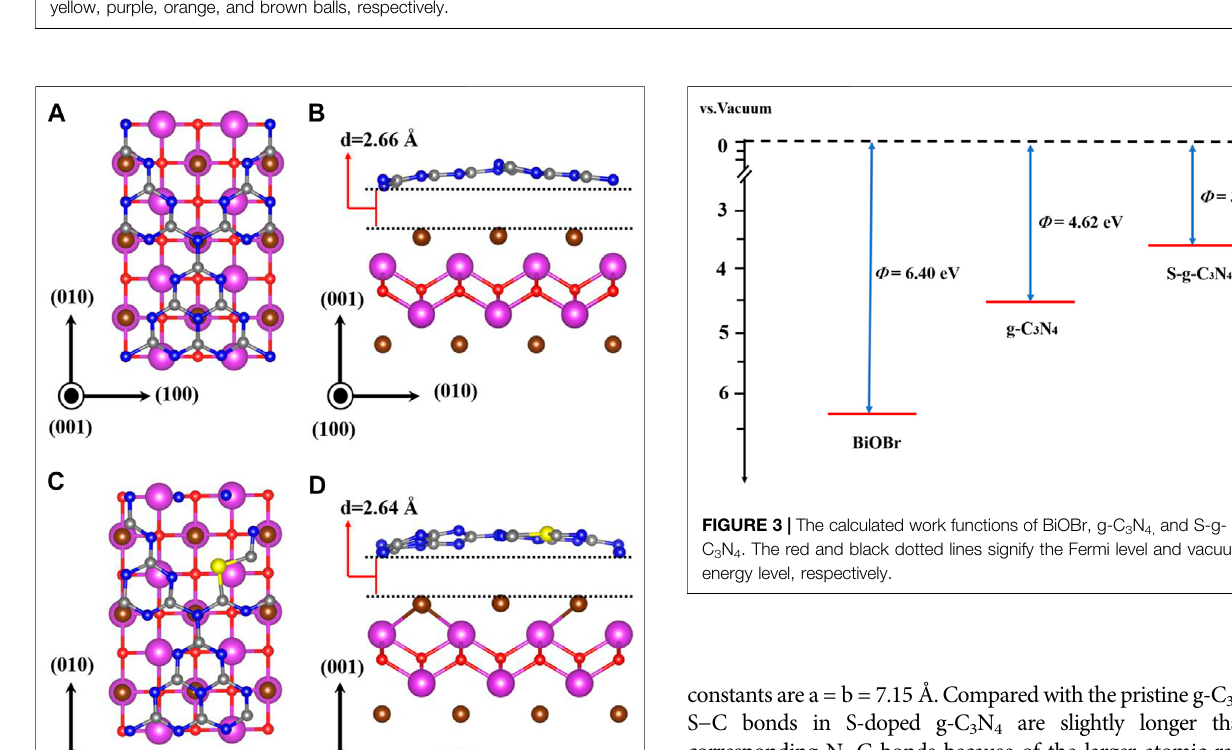
Frontiers in Nanotechnology |